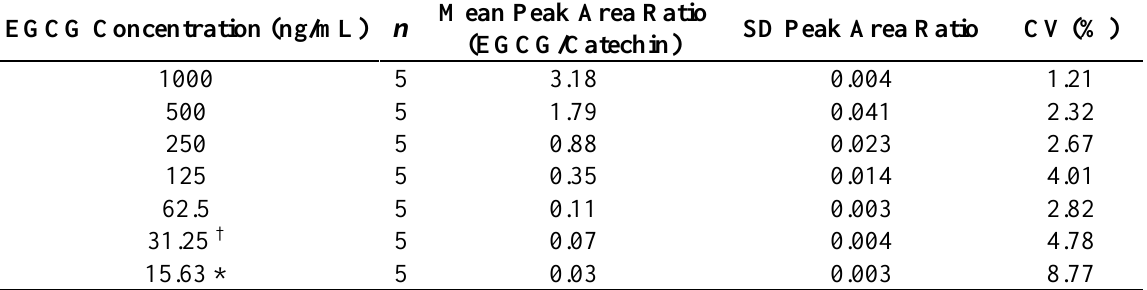
Table 3. Mean, standard deviation and coefficient of variation for seven concentrations of EGCG spiked into human plasma and detected using the optimised HPLC electrospray ionisation mass spectrometer (ESI-MS) system.